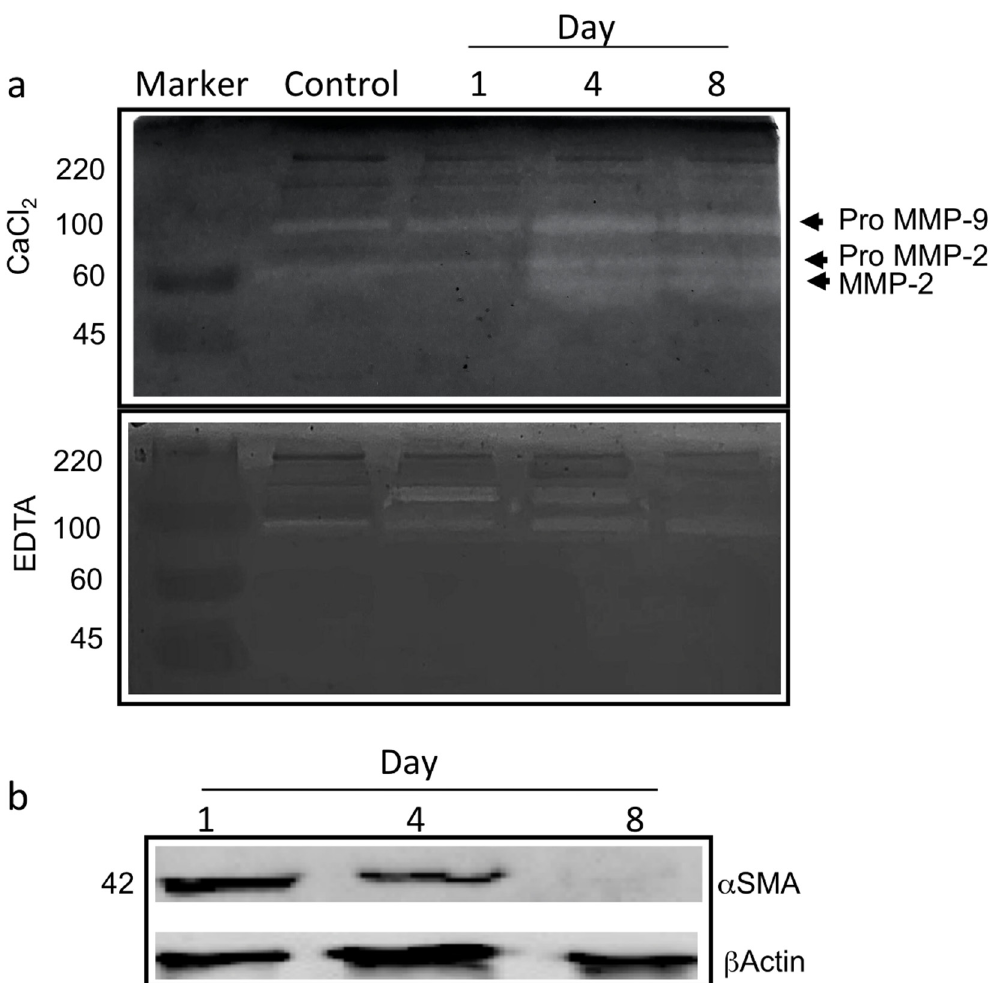
Figure 5. The angiogenesis in ad-MVFs occurred via the involvement of gelatinases and α SMA reduction. ( a ) Gelatine zymography (with CaCl 2 or EDTA) of proteins extracted from ad-MVFs cultured in 3D collagen hydrogel after 1 day, 4 days, and 8 days; protein extracted from 3D collagen hydrogel without cells was used as a negative control (Control). Activation of proMMP9 and proMMP2 is shown. ( b ) Western blotting analysis of proteins extracted from ad-MVFs cultured in 3D collagen hydrogel after 1, 4, and 8 days. A reduction in the total amount of α SMA is shown.